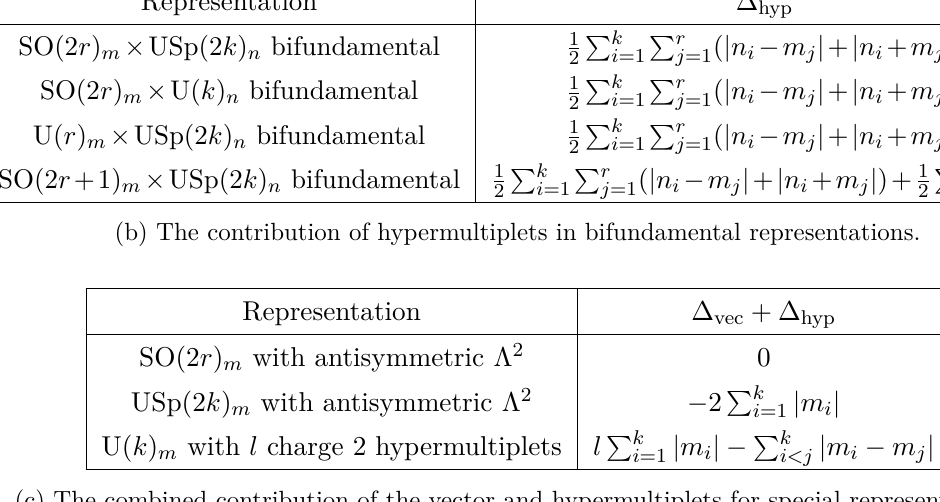
Table 2. Contributions to the conformal dimension ∆ that appear in the monopole formula (2.3). (a) summarises the vector mulitplet contributions, (b) collects the hypermultiplet contributions, and (c) provides the combined parts for certain special representations. Note in particular that a bifundamental of SO(2 r ) m × U( k ) n contributes exactly the same as a bifundamental of SO(2 r ) m × USp(2 k ) n and of USp(2 r ) m × U( k ) n , as required by the fact that U( k ) should be seen as a subgroup of USp(2 k )